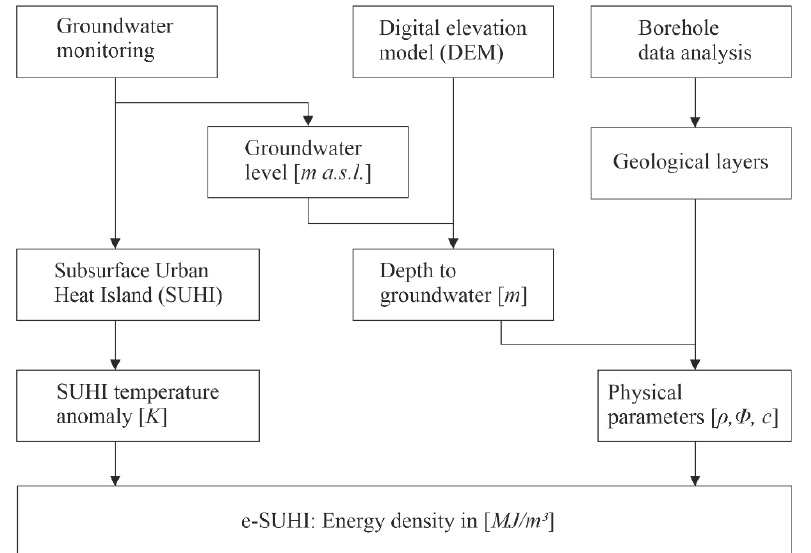
Figure 2. Workflow for the calculation of an energy-Subsurface Urban Heat Island (e-SUHI). The energy density in the subsurface caused by the SUHI is determined by temperature anomalies of the SUHI and physical rock parameters. We assume a subsurface temperature anomaly when the annual mean groundwater temperatures exceed 10.5